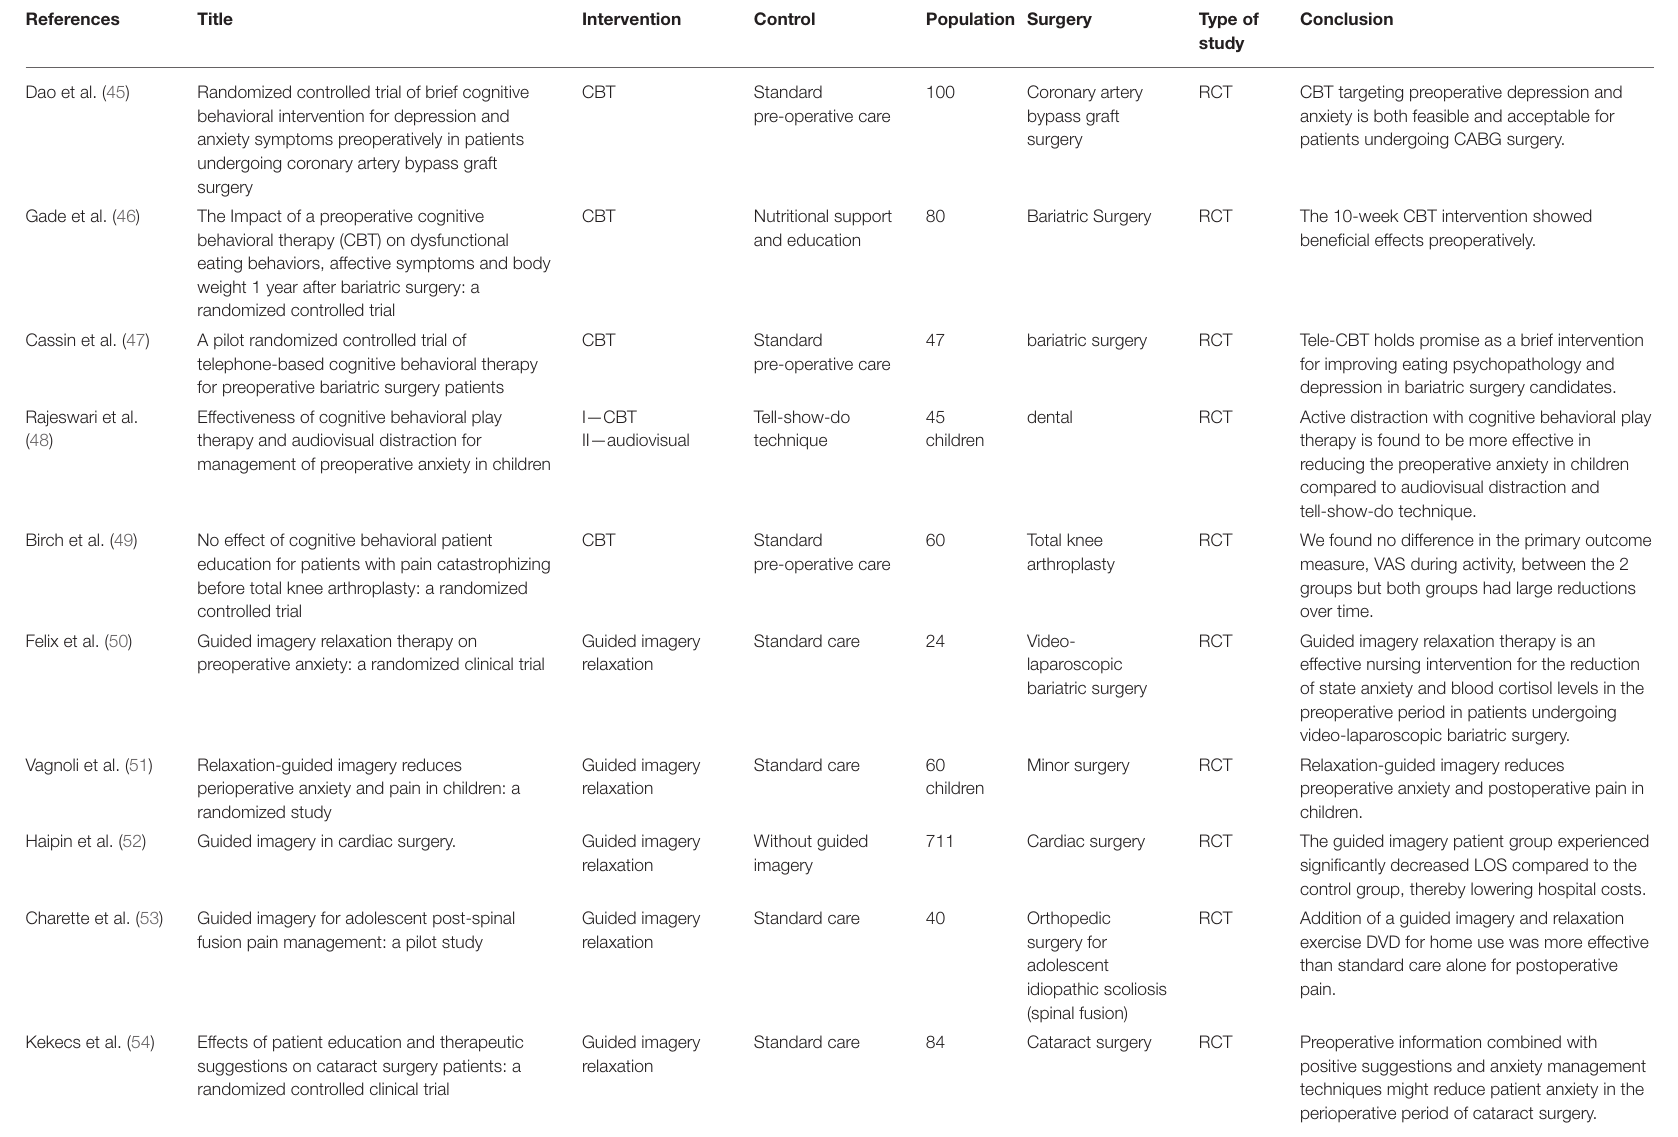
TABLE 1 | Clinical studies on cognitive behavioral therapy (CBT), guided imagery relaxation and hypnosis in preoperative